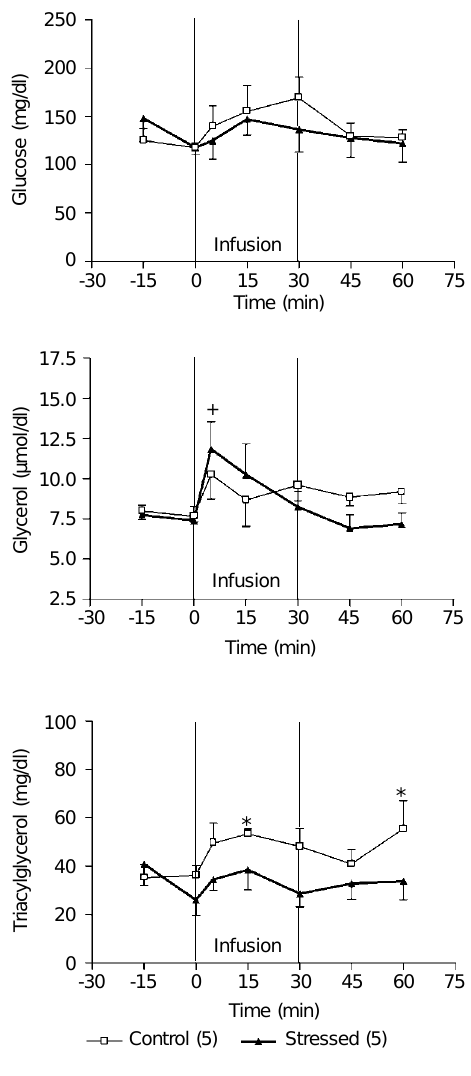
Figure 4. Effect of iv infusion of noradrenaline (5.0 µg kg -1 min -1 ) on plasma glucose, glycerol and triacylglycerol levels in fed con- scious rats after three daily ses- sions of confinement in foot- shock cages with no footshocks (control) or with footshock stress for 30 min. The infusion (time 0) began 15 min after the end of the third session. The points represent the means ± SEM of the number of rats indi- cated in parentheses. + P<0.05 compared to the value at 45 min; *P<0.05 compared to the val- ues at 0 and 30 min for the foot- shock group (ANOVA plus Tukey